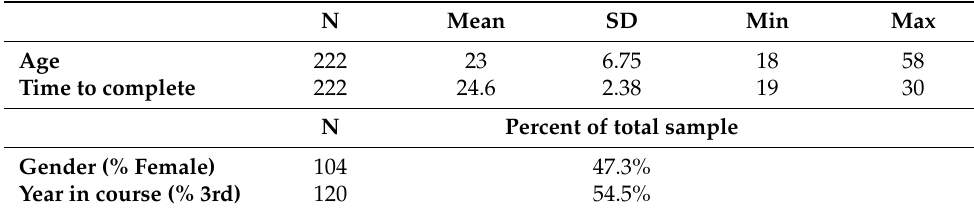
Table 1. Descriptive statistics of participants.